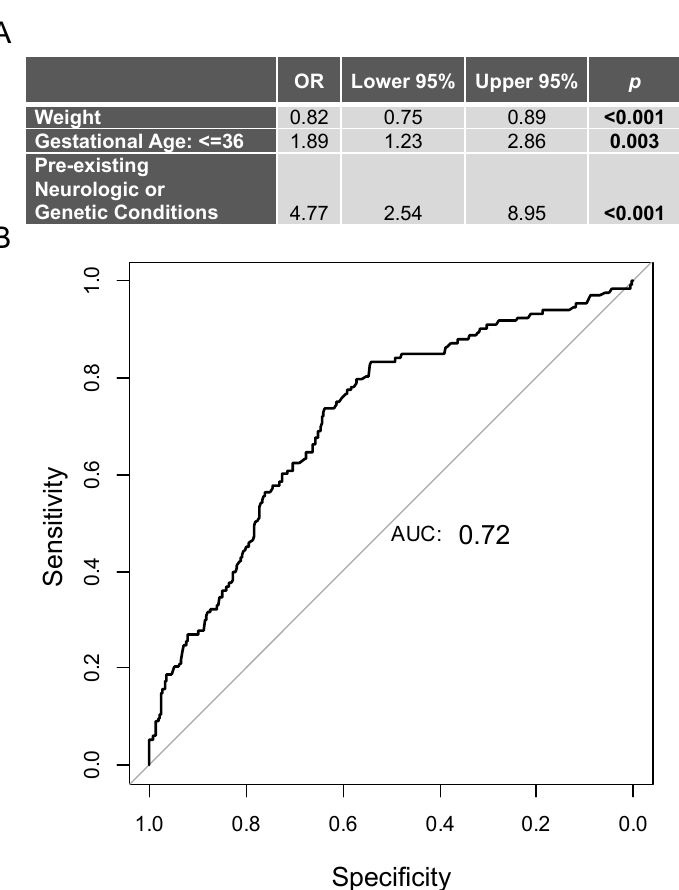
Figure 2. Predictive model for critical bronchiolitis patients requiring invasive mechanical ventilation. ( A ) Table of variables used to generate the predictive model. ( B ) Receiver operating characteristic (ROC) curve taking into account clinical characteristics with high odds of requiring mechanical ventilation. AUC = area under the curve.